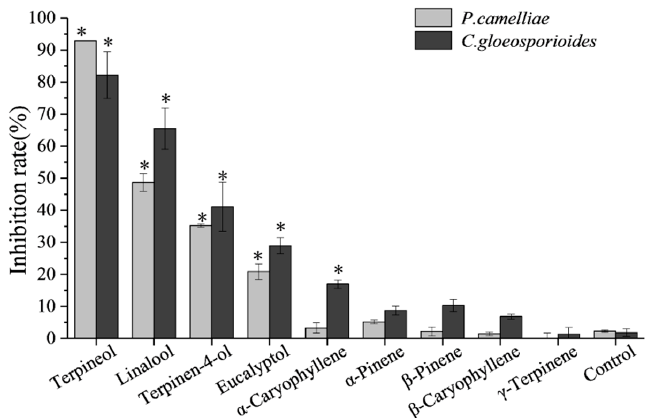
Figure 3. Fumigation activity of the ten main constituents available against P. camelliae and C. gloeosporioides at 200 μ L/L air after 5 days.